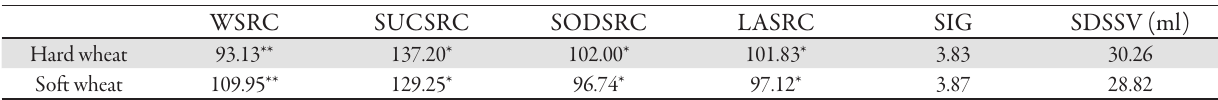
Tab. 3. wholemeal flour quality parameters of the soft and hard wheat